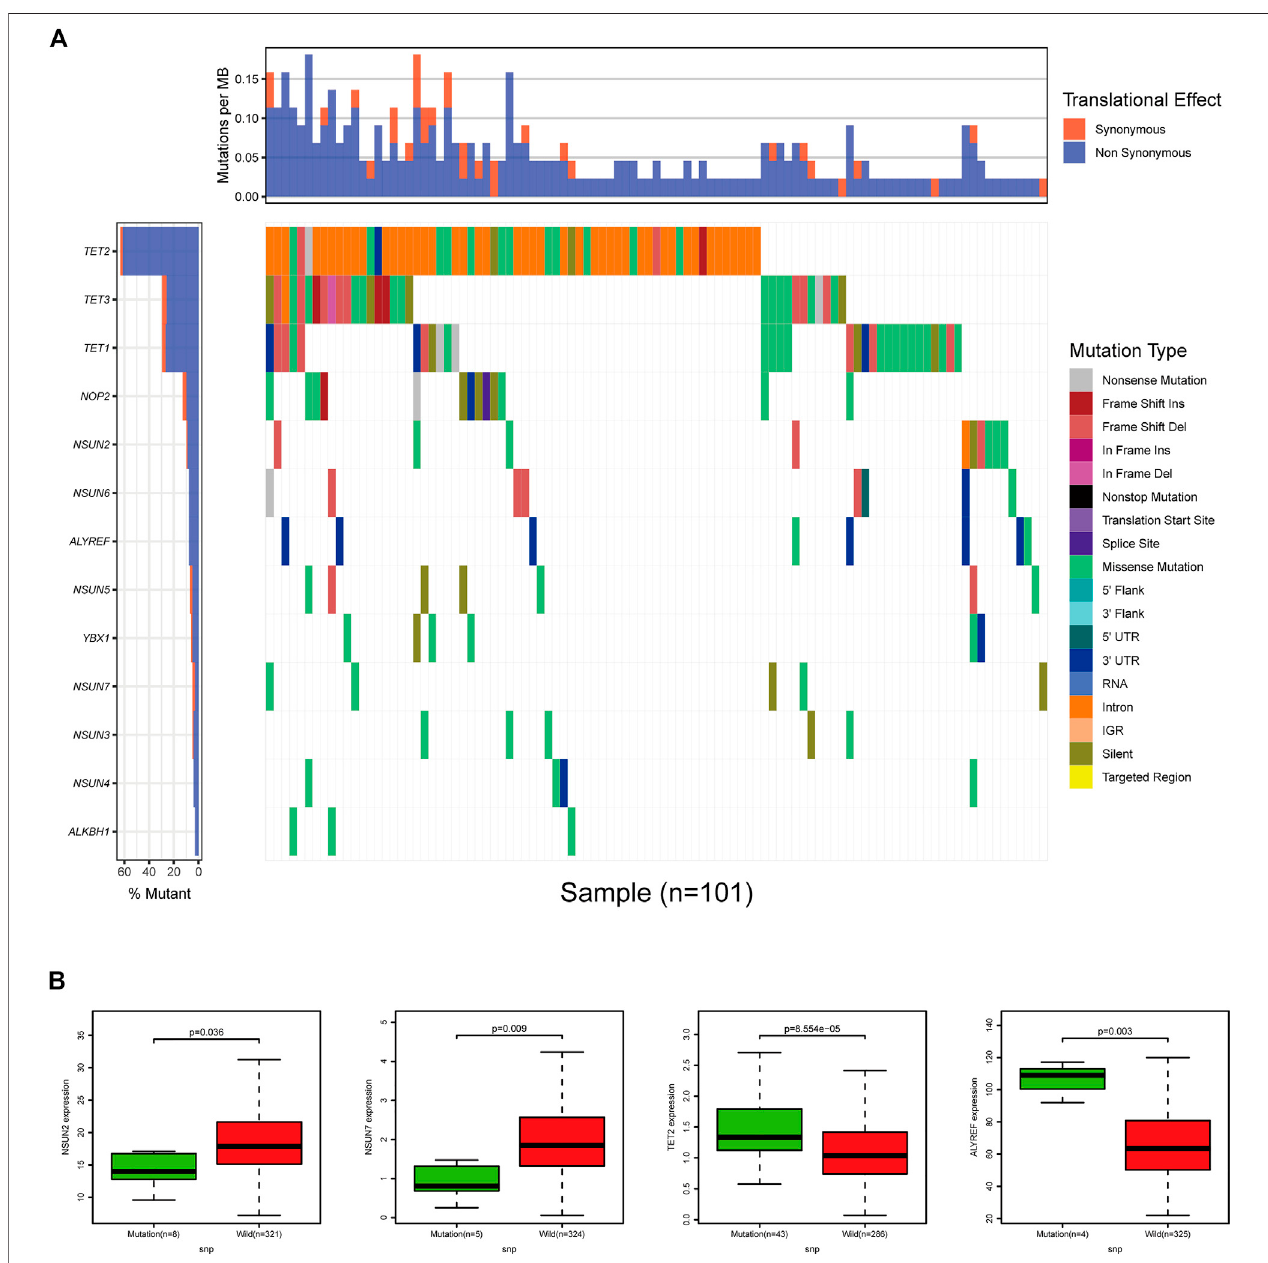
FIGURE5| ThelandscapeofSNPofm 5 C-relatedregulatorsinCOAD. (A) WaterfallplotofSNPof13 m 5 C-relatedregulatorsinCOAD. (B) NSUN2,NSUN7,TET2, and ALYREF displayed signi fi cant differences in expression levels due to SNPs.